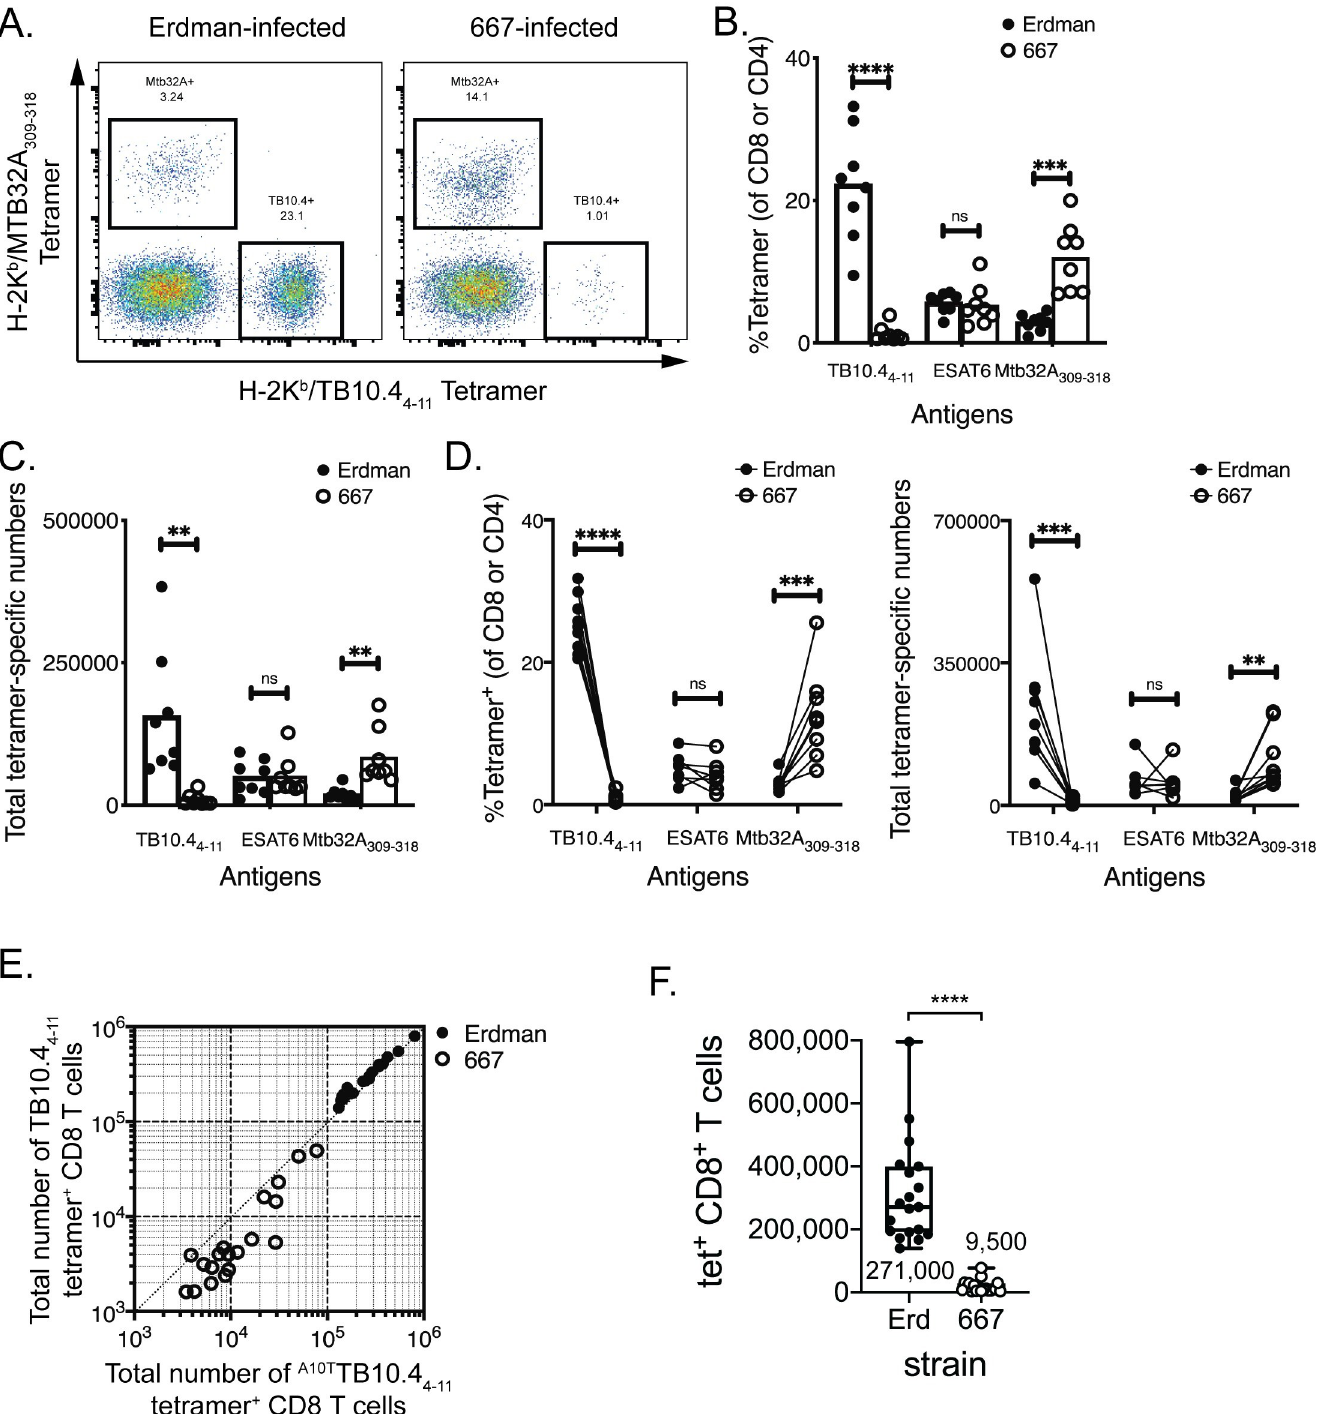
Fig 2. The hierarchy of immunodominant CD8 T cell responses after Erdman vs. 667 infection. Lung T cell responses were evaluated five weeks after infection of C57BL/6J mice with ~100 aerosolized Erdman or 667 bacilli. (A) Representative flow cytometry plots of MTB32a 309-318 and TB10.4 4 CD8 T cells from Erdman- or 667-infected C57BL/6J mice. The frequency (B) or absolute number (C) of TB10.4- or MTB32a-specific CD8, or ESAT6-specific CD4 T cells in the lungs of infected mice after Erdman or 667 infection. (D) The frequency (left) and total numbers (right) of Mtb-specific CD4 or CD8 T cells, from nine independent paired Erdman (closed symbols) and 667 (open symbols) infections. Each point is the average of 4–8 mice and lines connect the paired infections. (E) The number of TB10.4-specific CD8 T cells in the lungs of mice infected with Erdman (closed symbols) or 667 (open symbols) was quantified by staining the different cell